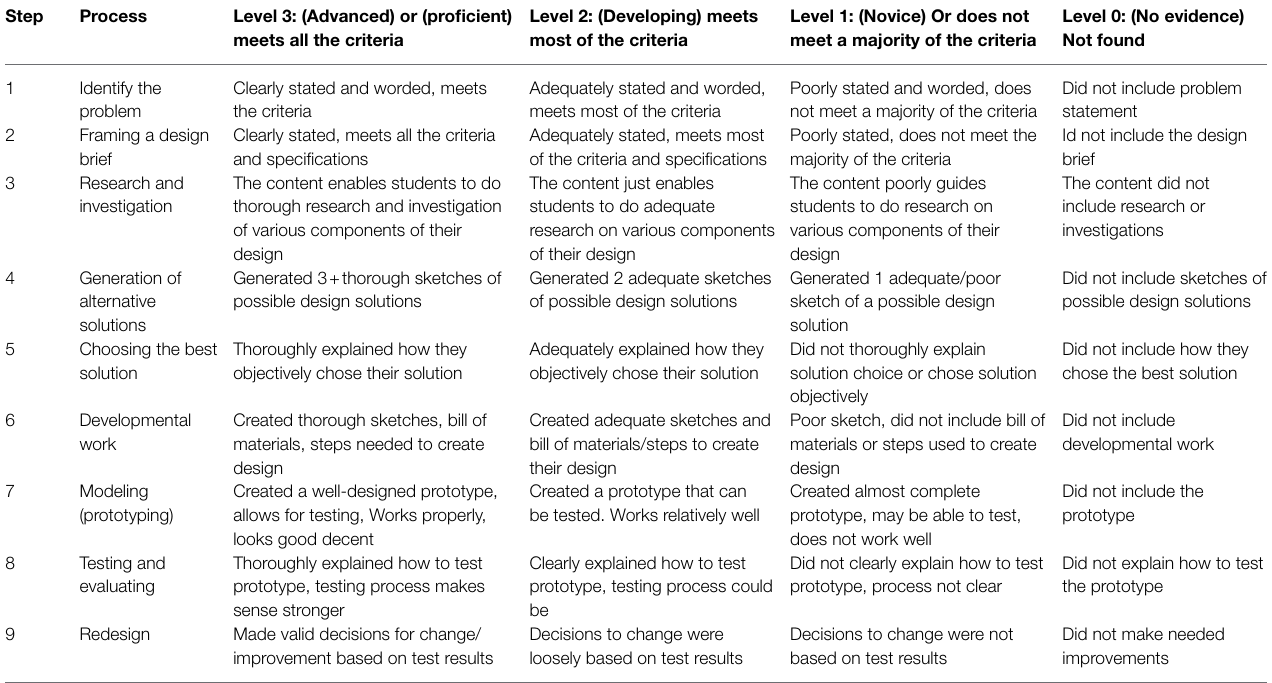
TABLE 1 | The rubric for analyzing the inclusion of engineering design process and their levels.